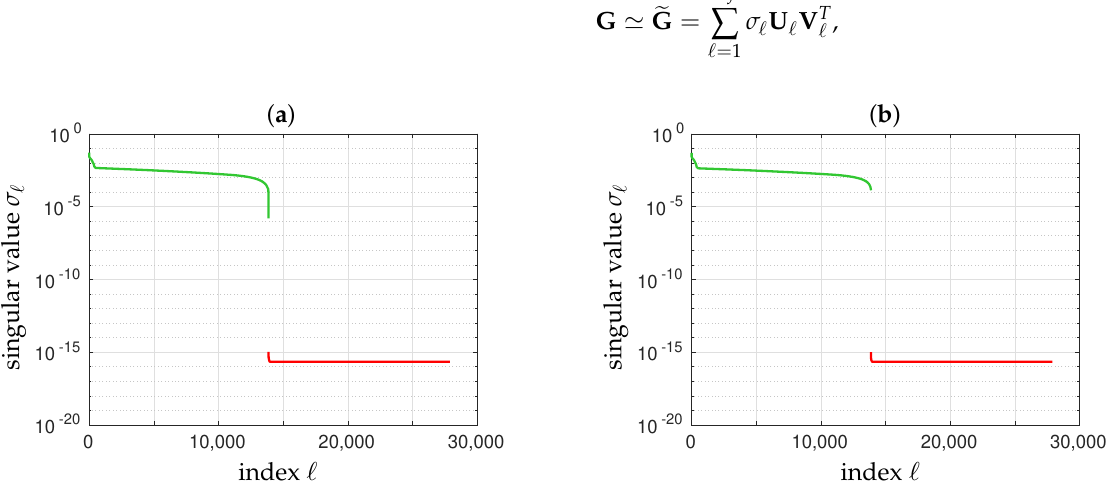
Figure 5. Distributions of the singular values of the modeling matrix G of the cross-shaped array shown in Figure 4 for two values of the shortest spacing: ( a ) d = 0.69 λ and ( b ) d = 0.71 λ . In every case, two groups of singular values separated by a well-determined gap are observed: the first group (green) is composed of the 13861 largest singular values, the second one (red) of the remaining smallest ones that could be considered as being equal to